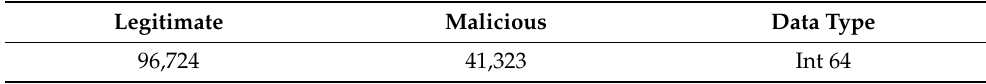
Table 1. Legitimate file classification